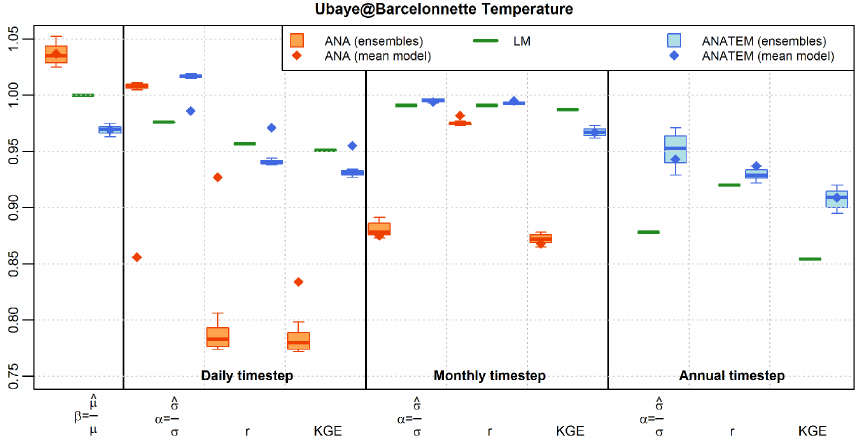
Figure 7. Daily, monthly and annual performance criteria of air temperature reconstructions for the Ubaye River at Barcelonnette watershed by the analogue (ANA), local (LM) and ANATEM models. For the annual time step, ANA results are smaller than 0.75; they therefore do not appear in the figure.